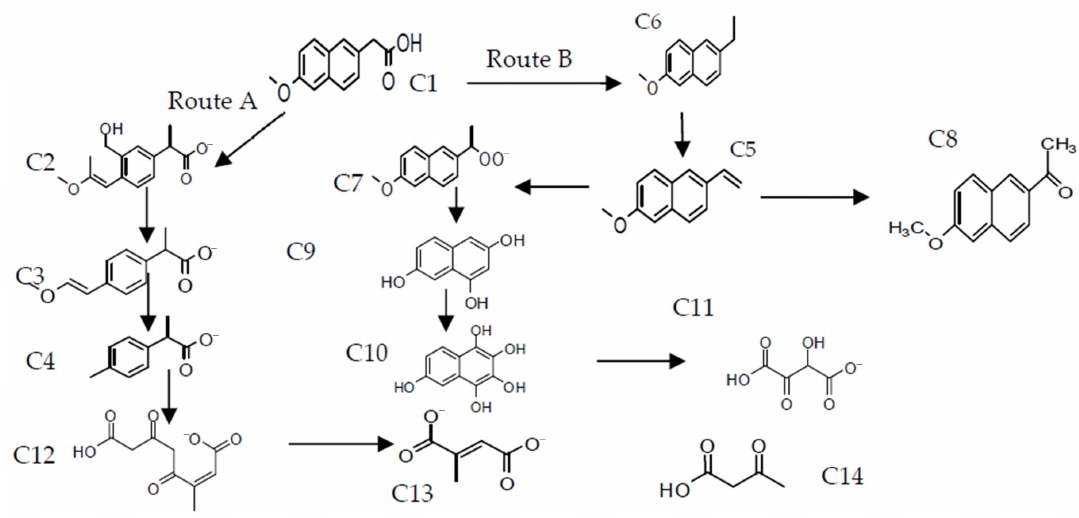
Figure 8. Proposed reaction pathway for the degradation of NAP by CWPO. Regarding the DCF byproducts from the treated CWPO sample, the proposed struc- tures of intermediates after 3 h reaction time at the specified operating conditions are listed in Table S4 (Supplementary Material). In contrast to other advanced oxidation technologies, the number of found intermediate compounds was considerably lower [44]. Based on the intermediates identified by ESI–LC–MS, a reaction pathway for the degradation of DCF by CWPO was proposed (Figure 9).